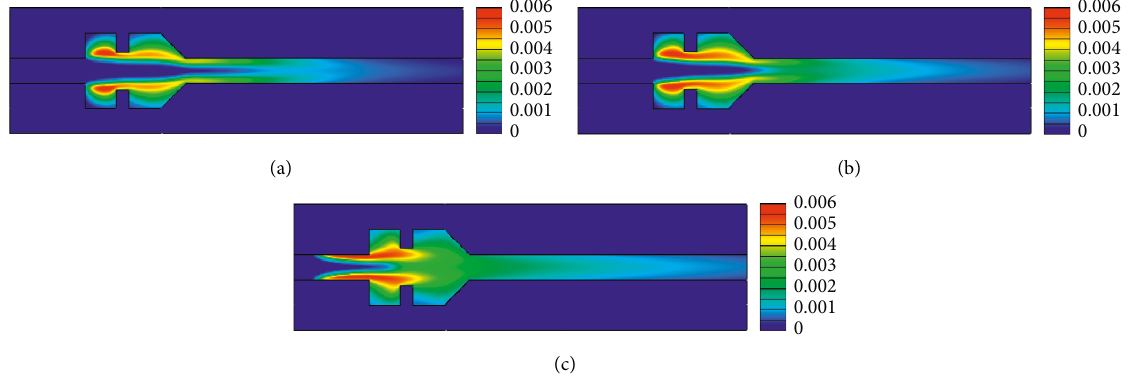
Figure 12: OH distribution of the improved microcombustor at equivalence ratios: (a) Φ � 0.4, (b) Φ � 0.5, and (c) Φ � 0.6.